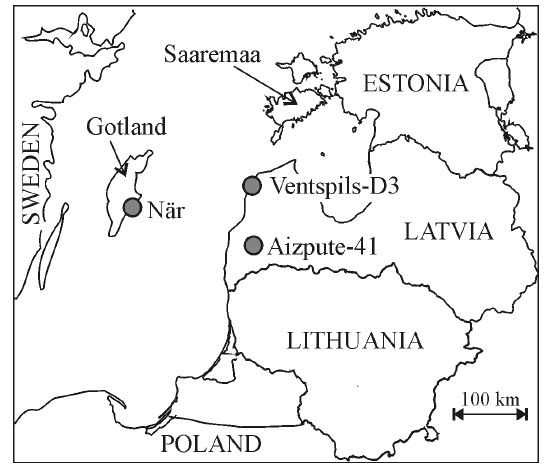
Fig. 1. Location of the studied